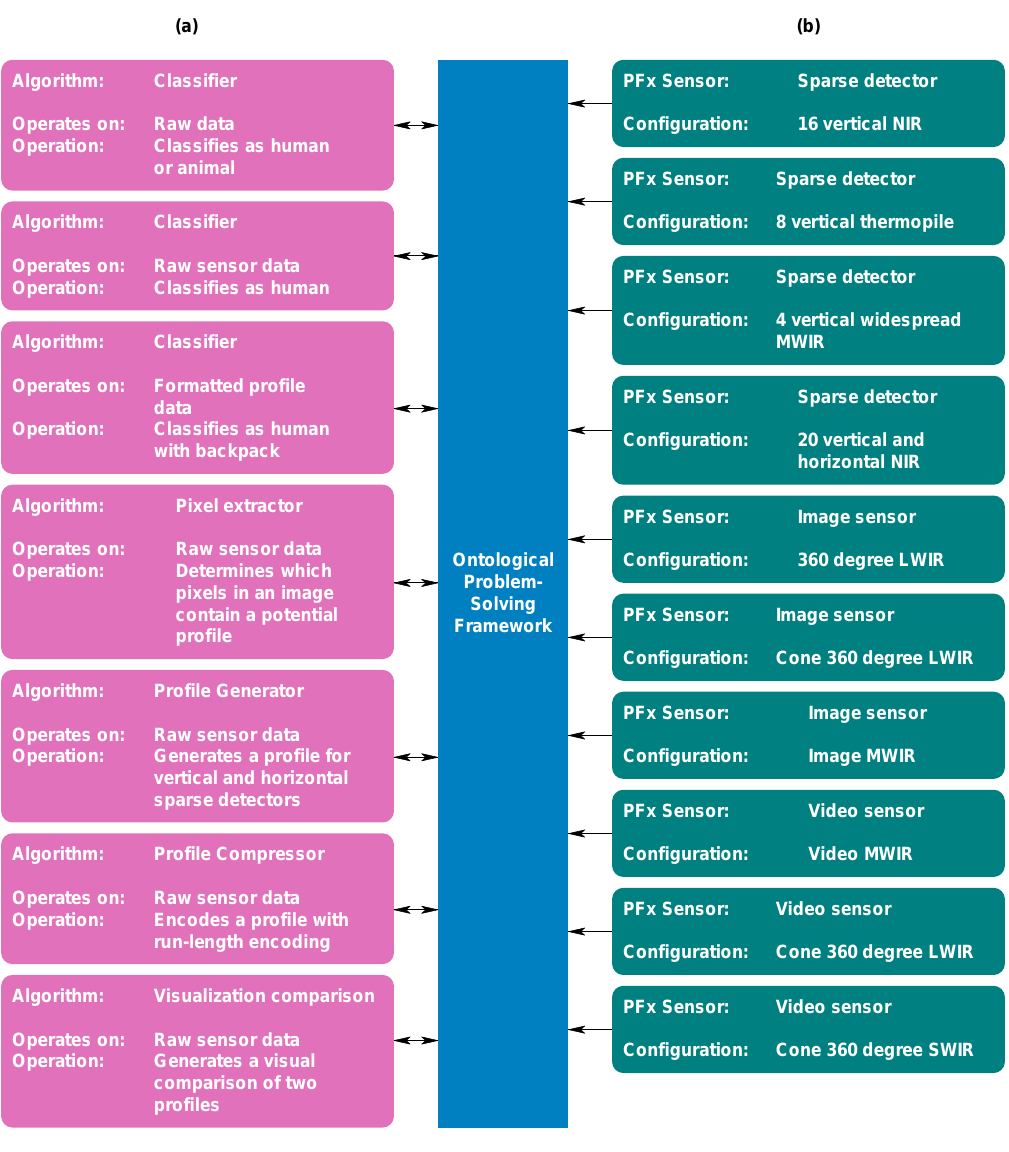
Figure 9. (a) Representative algorithm types, including classifiers, visualizers, and silhouette generators. (b) Representative PFx sensor types, including sparse detectors and